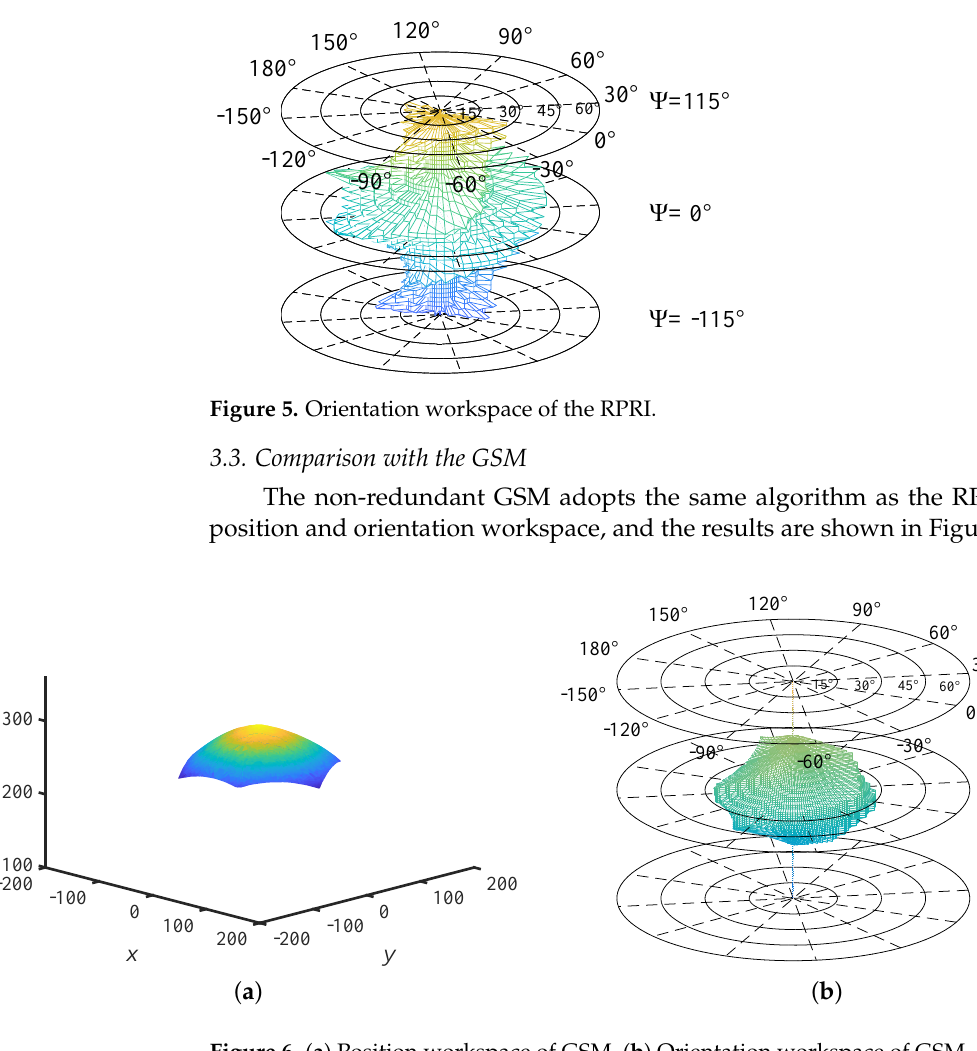
Figure 6. ( a ) Position workspace of GSM. ( b ) Orientation workspace of